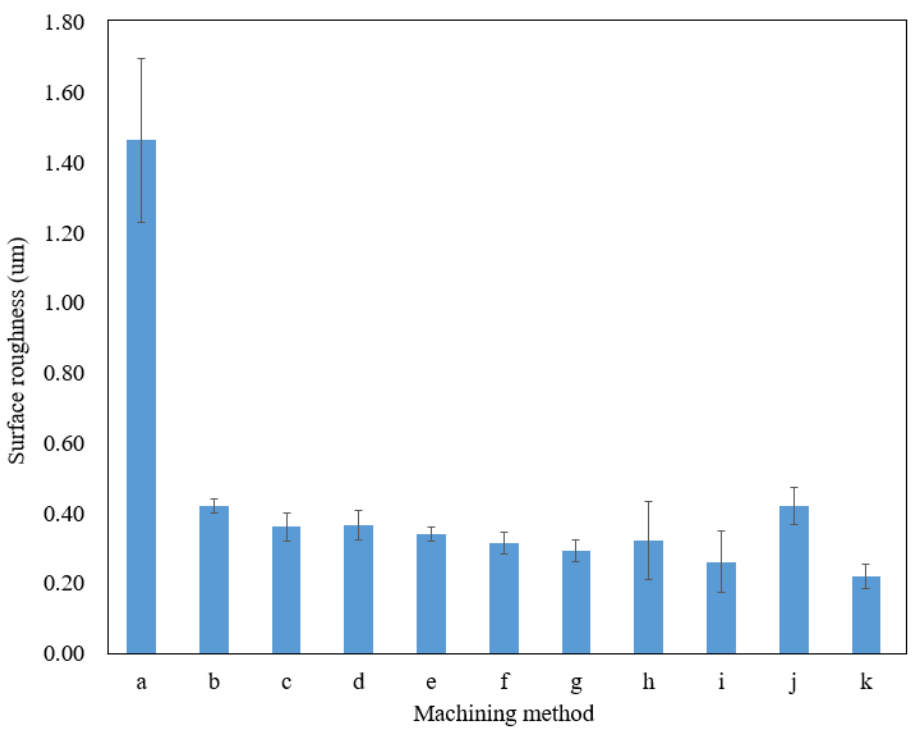
Figure 6. The surface roughness of the sidewall on a microfluidic channel of different machining methods and parameters. (a) Wire EDM; (b) 15 V, 15 vol.%, 10 mm; (c) 15 V, 20 vol.%, 20 mm; (d) 15 V, 25 vol.%, 30 mm; (e) 20 V, 15 vol.%, 20 mm; (f) 20 V, 20 vol.%, 30 mm; (g) 20 V, 25 vol.%, 10 mm; (h) 25 V, 15 vol.%, 30 mm; (i) 25 V, 20 vol.%, 10 mm; (j) 25 V, 25 vol.%, 20 mm; (k) 20 V, 20 vol.%, 10 mm (optimum parameters).